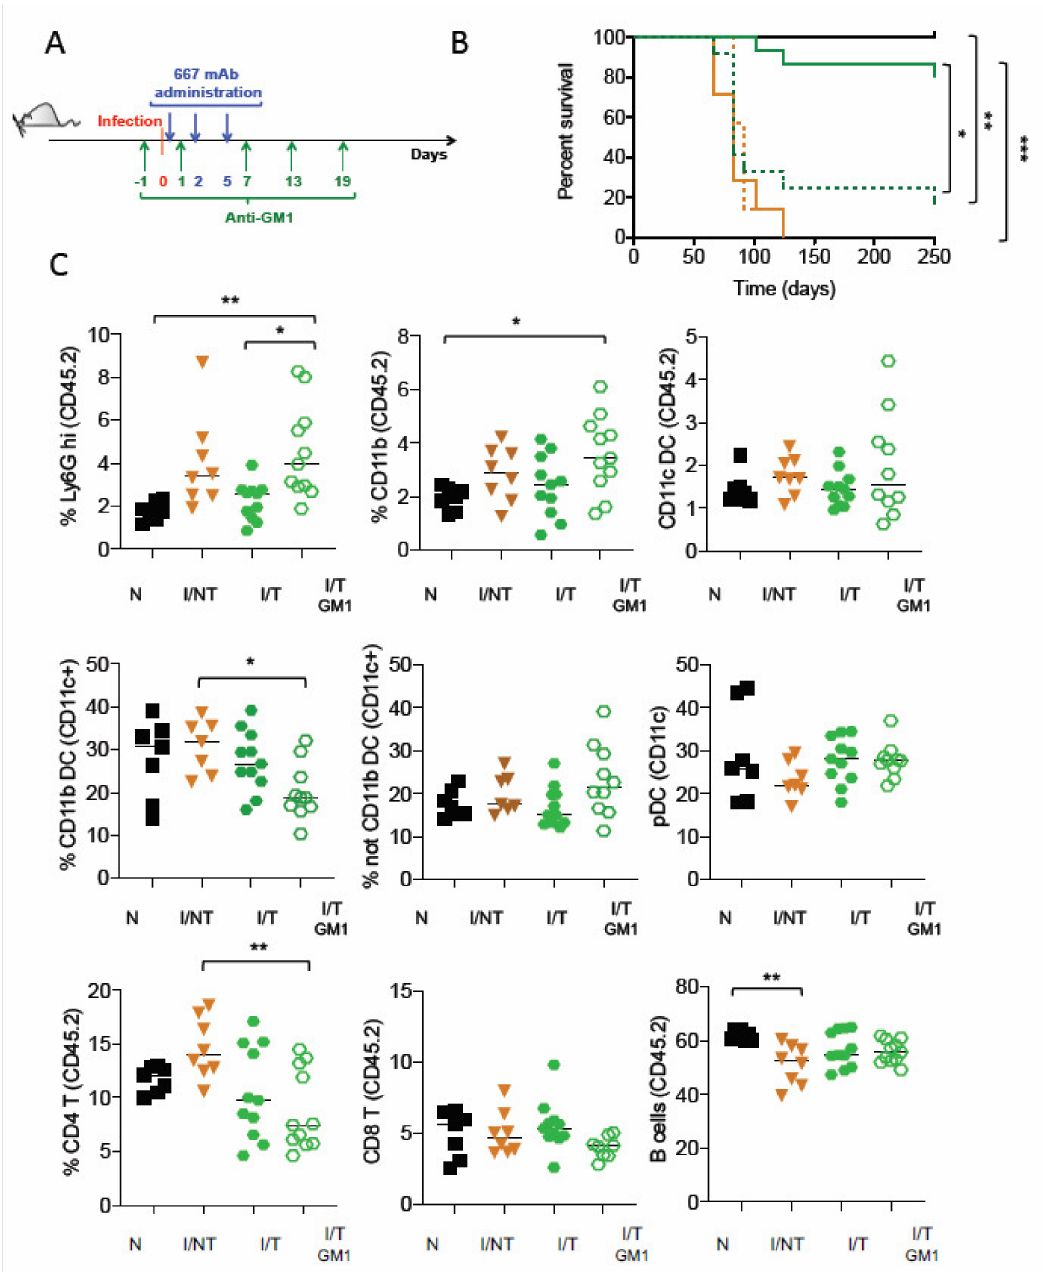
Figure 2. The effect of NK cell depletion in disease progression and in the recruitment of immune cells upon FrCasE infection and mAb treatment : ( A ) mice were infected with the FrCasE retrovirus and treated or not with the 667 mAbs as in Figure 1. Infected mice were treated as indicated with the anti-asialo-GM1 antibody to deplete NK cells. This depleting antibody was injected 1 day before infection and at days 1, 7, 13 and 19 p.i.; ( B ) effect of NK cell depletion on the survival of infected/non-treated and infected/treated mice. The data correspond to 2 independent experiments with the following number of mice per group: naïve (solid black line) ( n = 6); naïve-GM1 (dotted black line, overlapping with solid black line) ( n = 5), infected/non-treated (solid orange line) ( n = 7); infected/non-treated-GM1 (dotted orange line) ( n = 7); infected/treated ( n = 15) (solid green line); infected/treated-GM1 (dotted green line) ( n = 12); ( C ) frequency of immune cells in the spleen at days 14 p.i. measured in the CD45.2 + leukocytic population. The data correspond to at least 3 independent experiments with the following number of mice per group: naïve ( N ) ( n = 7); infected/non-treated (I/INT) ( n = 8); infected/treated (I/T) ( n = 11), infected/treated-GM1 (I/T GM1) ( n = 11, except for CD8 ( n = 8) and DCs n = 10). (* p < 0.05; ** p < 0.01; *** p <